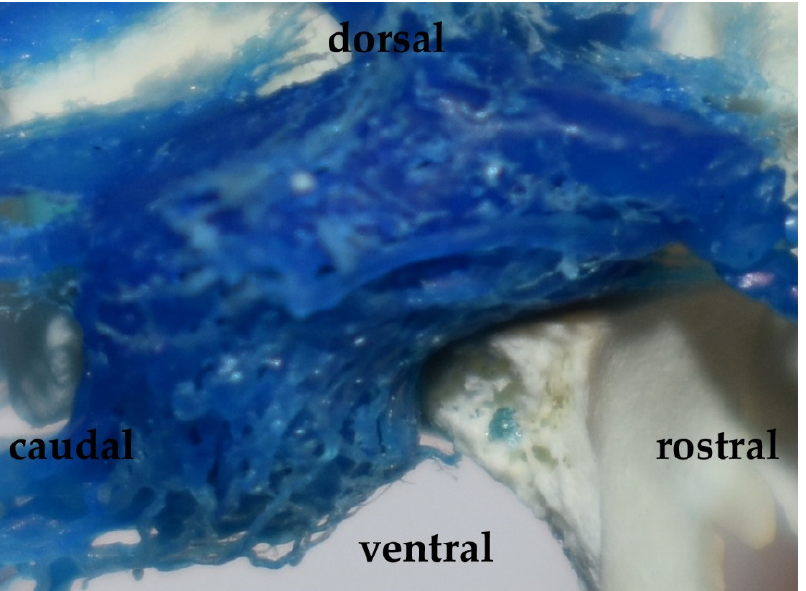
Figure 4. The cavernous sinus in the Eurasian wild boar ( Sus scrofa ). A lateral view and corrosion cast.